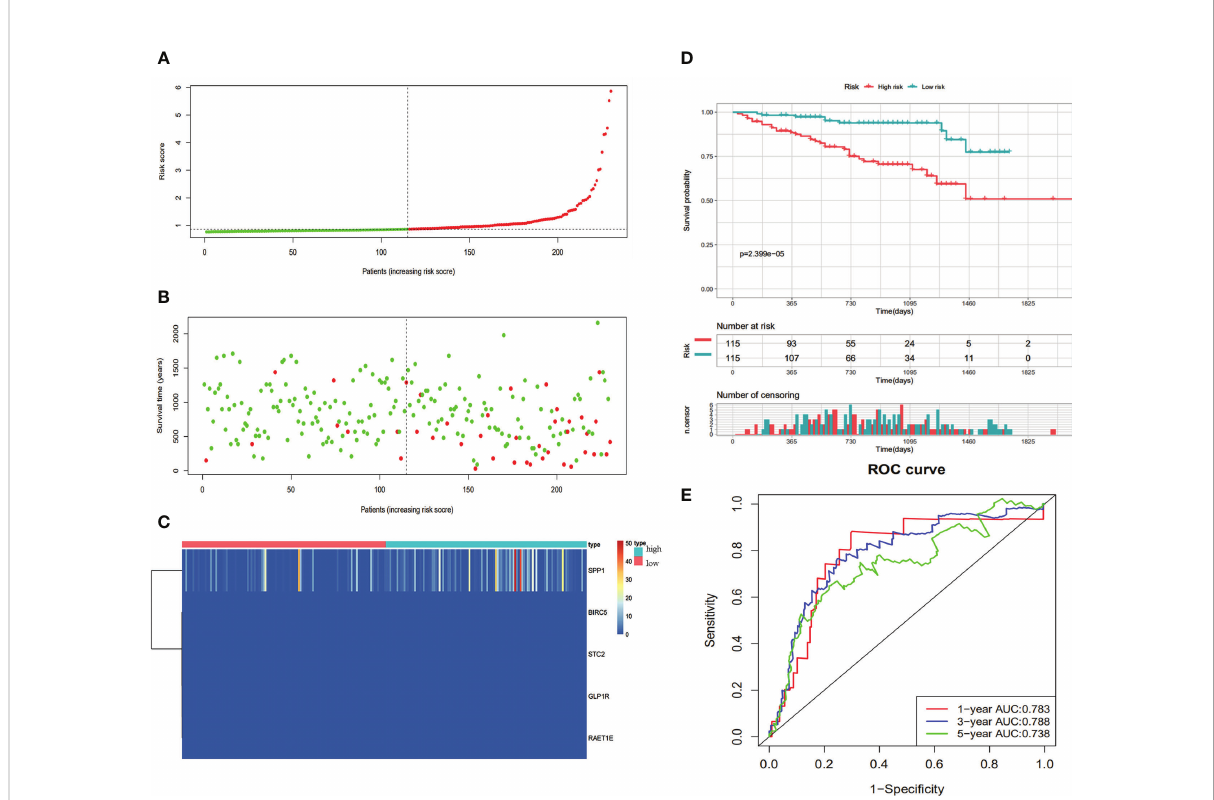
FIGURE 5 Validation of the immune-based prognostic risk signature in the ICGC cohort. (A) The risk score distribution of HCC patients. (B) Survival status and duration of patients. (C) Heatmap of the expression of the immune-related genes. (D) Survival curves for the low risk and high-risk groups. (E) Time-independent ROC analysis of risk scores for prediction the overall survival in the ICGC